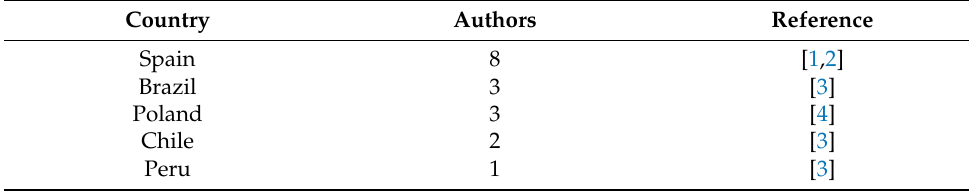
Table 1. Distribution of the authors’ nationality.